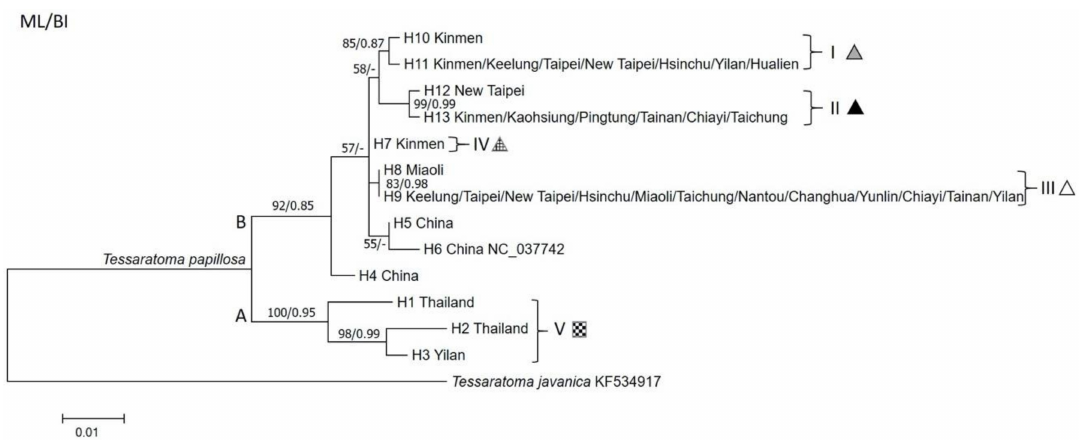
Figure 5. Maximum-likelihood phylogeny of LSB based on mitochondrial COI sequences. Numbers at the nodes represent maximum-likelihood bootstrap values and Bayesian posterior probabilities.